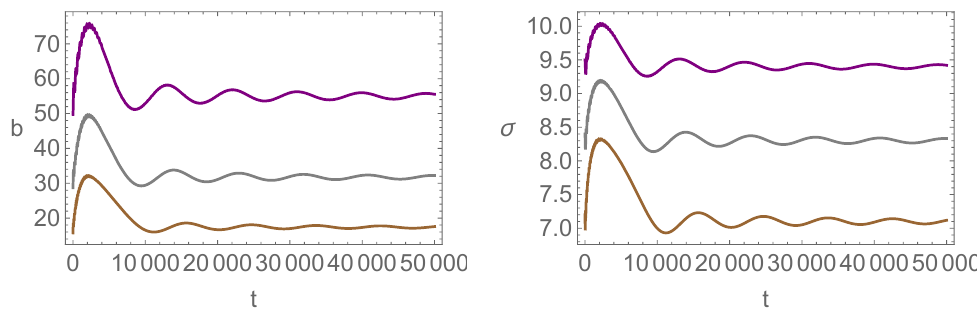
= 7 . 1 , 8.3, 9.4, which correspond to ∗